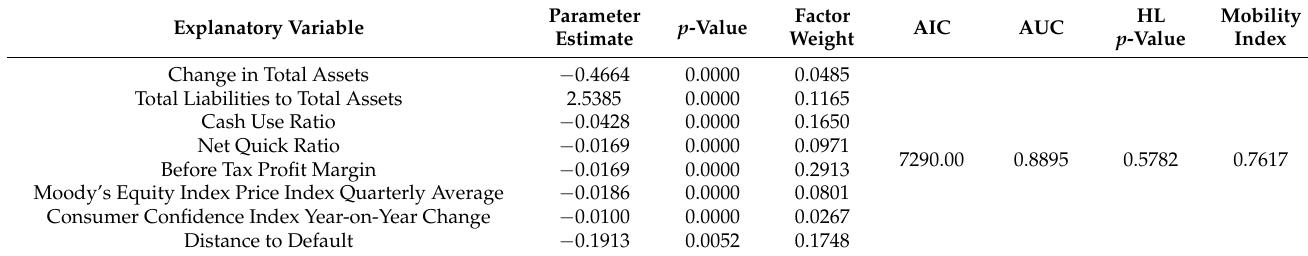
Table 9. Logistic Regression Estimation Results—Moody’s Large Corporate Financial, Macroeconomic and Distance-to- Default Explanatory Variables 1-Year Default Horizon PIT Hybrid Reduced Form/Structural-Merton Model